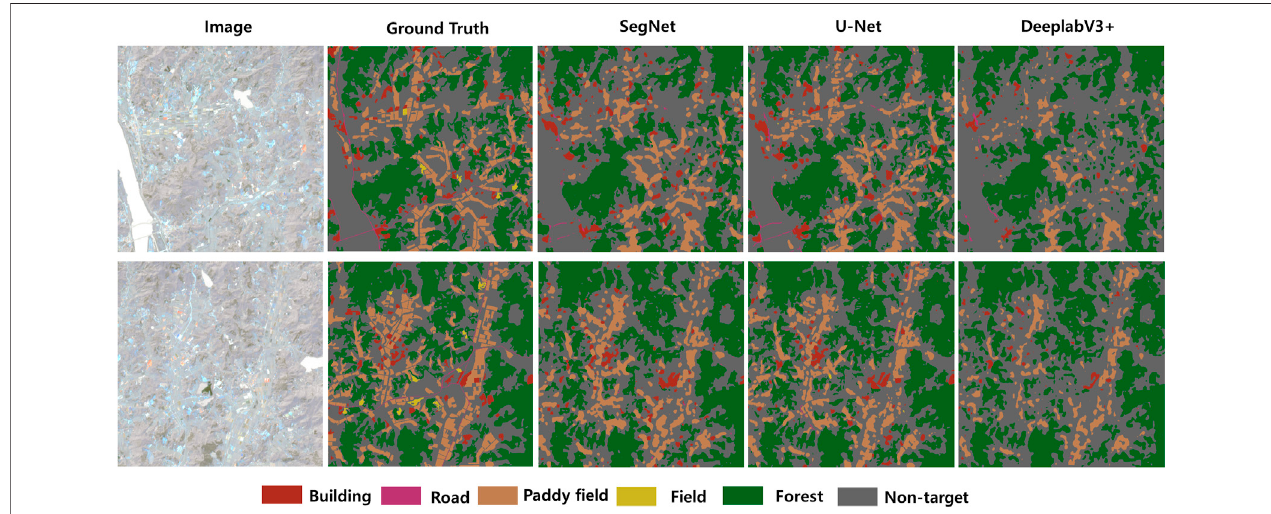
FIGURE 7 | Result satellite image of SegNet, U-Net and DeeplabV3+ algorithms.